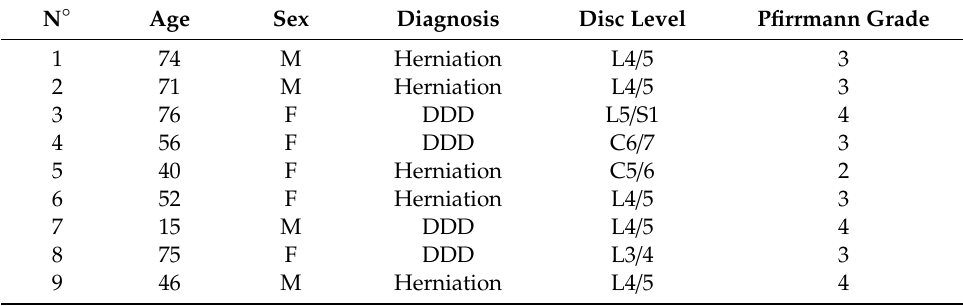
Table 1. Patient characteristics: F = female; M = male; DDD = degenerative disc disease; L = lumbar; C =